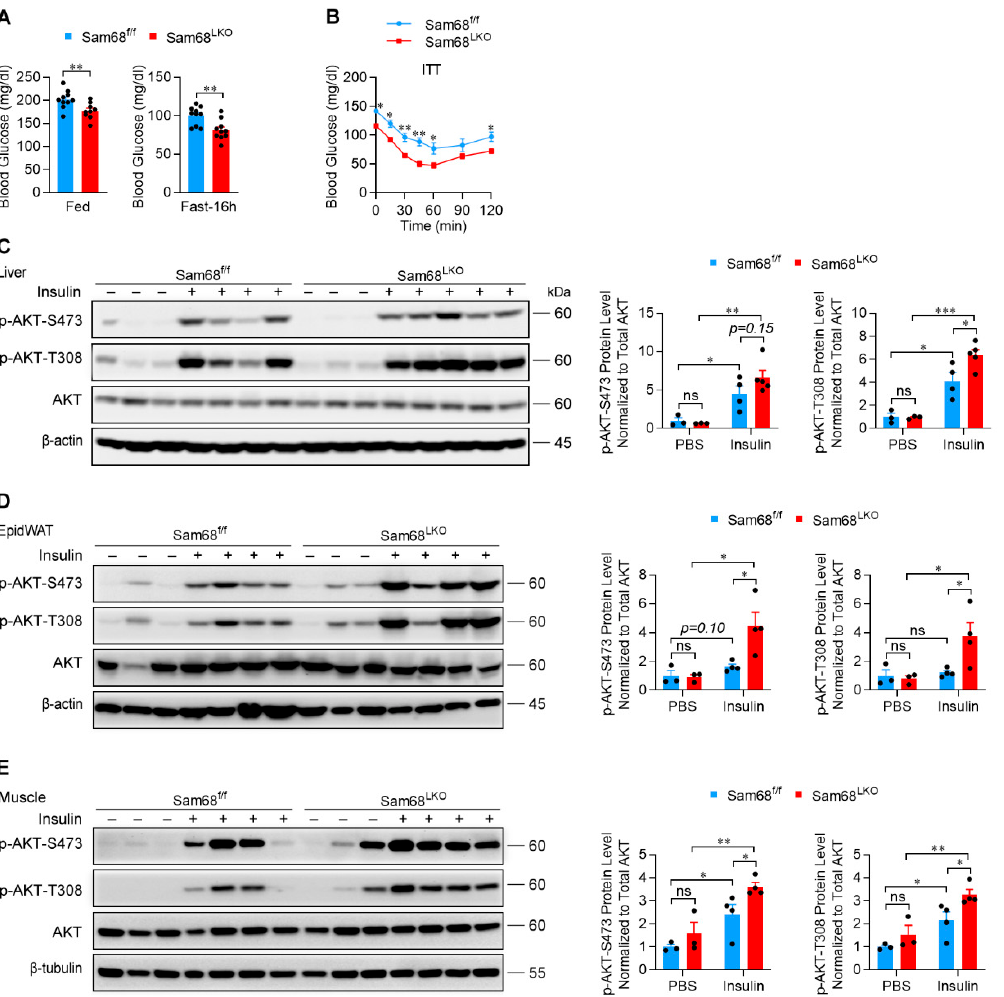
Figure 6. Deletion of hepatic Sam68 improves systemic insulin sensitivity in HFD-fed mice. Four-week-old Sam68 LKO and Sam68 f/f mice were fed with HFD for twelve weeks and analyzed. ( A , B ) Blood glucose levels were measured in mice ( A ) under feeding conditions or after 16 h fasting ( n = 9–10) and ( B ) in the ITT (insulin tolerance test; n = 7–8). ( C – E ) Sam68 LKO and Sam68 f/f mice were intraperitoneally injected with insulin (+) or PBS (–); 20 min later, ( C ) liver ( n = 3–5); ( D ) epiWAT ( n = 3–4), and ( E ) skeletal muscle tissues ( n = 3–4) were harvested, and the protein levels of phosphorylated AKT (at amino acids Ser-473 and Thr-308) and total AKT were evaluated (left panel, representative Western blot; right panel, quantification). Data are expressed as mean ± s.e.m. * p < 0.05, ** p < 0.01, *** p < 0.001, ns, not significant (( A ): unpaired t test; ( B – E ): two-way ANOVA).